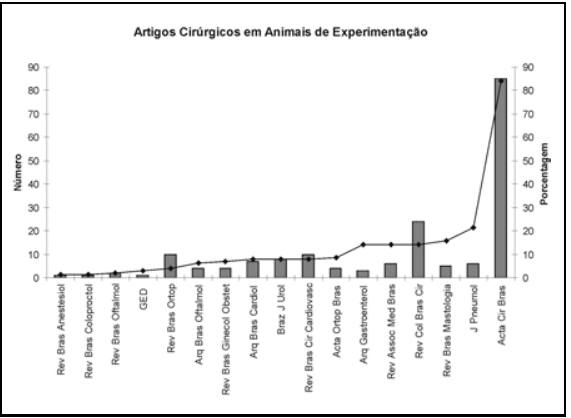
FIGURA 3 (cid:150) GrÆfico que mostra a porcentagem crescente dos artigos cirœrgicos originais, segundo o aspecto de estudo em animais de experimenta(cid:231)ªo.